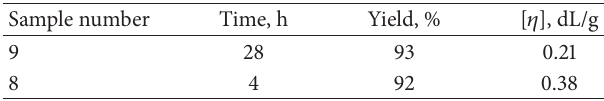
Table3:EMROPofpentadecalactone.Dependenceofproductyield and polymer intrinsic viscosity on reaction time.